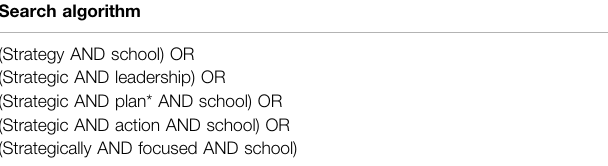
TABLE 1 | Key search algorithm. Search algorithm (Strategy AND school) OR (Strategic AND leadership) OR (Strategic AND plan* AND school) OR (Strategic AND action AND school) OR (Strategically AND focused AND school)